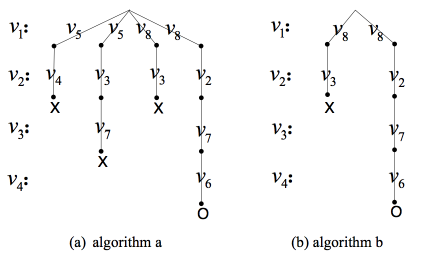
Figure 10. An example of calling the recursive function and backtracking.